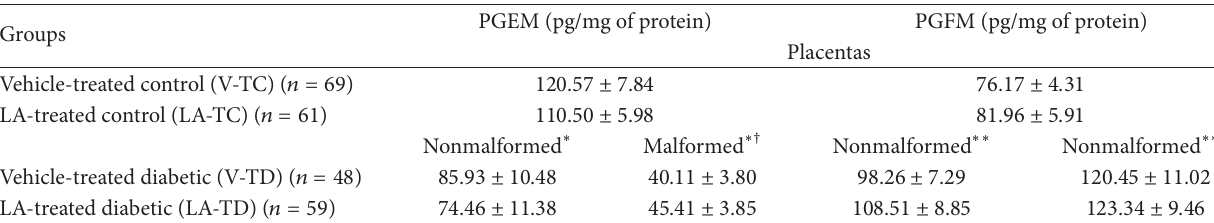
Table 9: PGEM and PGFM in